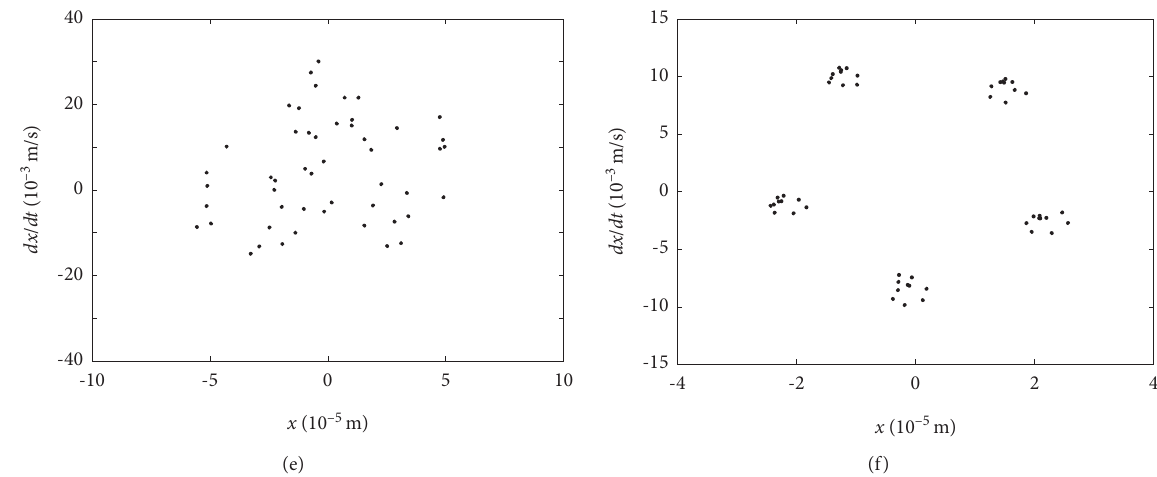
Figure 17: Poincar´e maps of disk 4 with rub-impact during level flight. (a) 220rad/s. (b) 226 rad/s. (c) 236rad/s. (d) 252rad/s. (e) 256rad/s. (f)